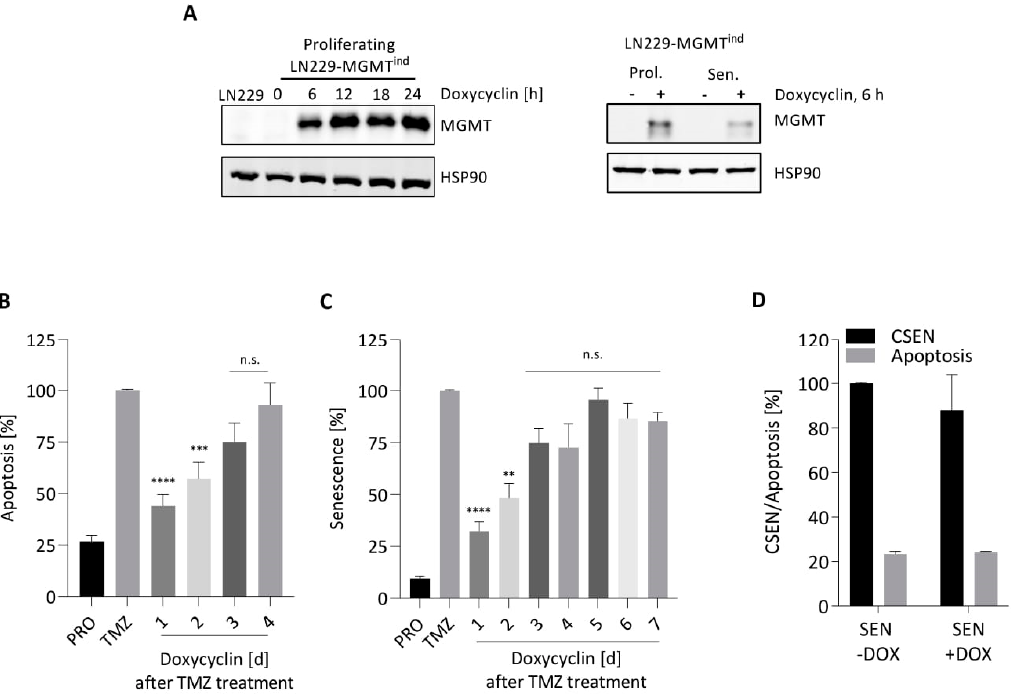
Figure 5. O 6 MeG is required for induction of apoptosis and CSEN, but not for maintenance of the senescent state. ( A ) Proliferating and senescent LN229-MGMT ind cells show strong induction of MGMT following doxycycline treatment. ( B , C ) LN229-MGMT ind cells were treated with 50 µM TMZ and 100 ng/mL doxycycline for the indicated times, and apoptosis ( B ) and CSEN ( C ) were measured 5 and 10 days following TMZ treatment, respectively. ( D ) The senescent population obtained 8 days after TMZ treatment (50 µM) was not treated (CSEN) or treated with doxycycline; 48 h later, apoptosis and CSEN were measured by flow cytometry. Induction of MGMT had no impact on their levels. Data are the mean of three independent experiments ± SEM. ** p < 0.01, *** p < 0.001; **** p < 0.0001; n.s. = not significant.